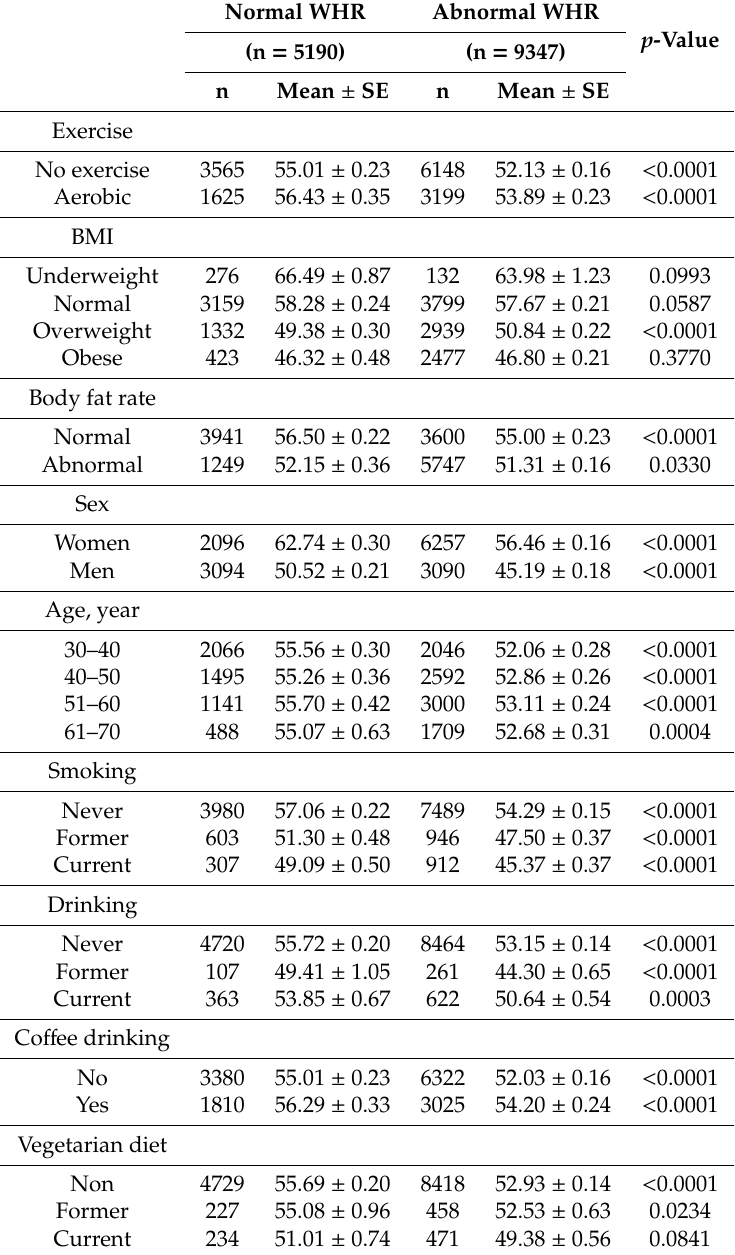
Table 1. Mean HDL-C levels of participants categorized by waist-hip ratio